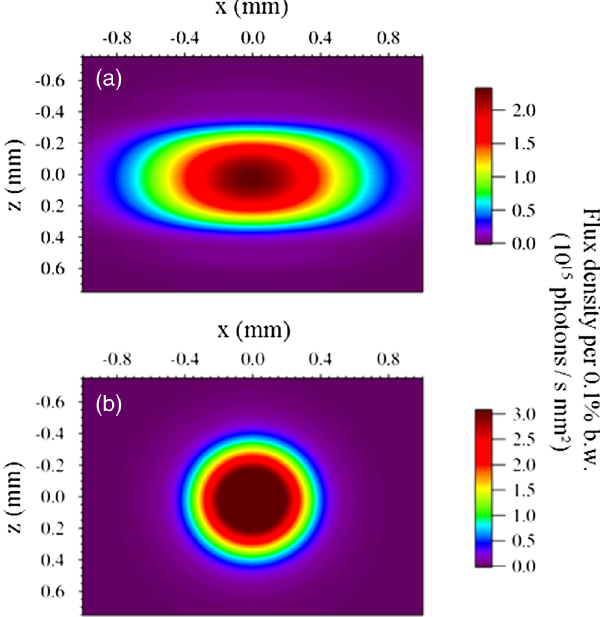
FIG. 4. Photon flux density reconstructed at the diaphragm ( s ¼ 10 m) of the SEXTANTS beam line for flat (a) and round beam (b) configurations. Corresponding electron beam sizes and divergences are given in Table I. The photon energy is 780 eV.